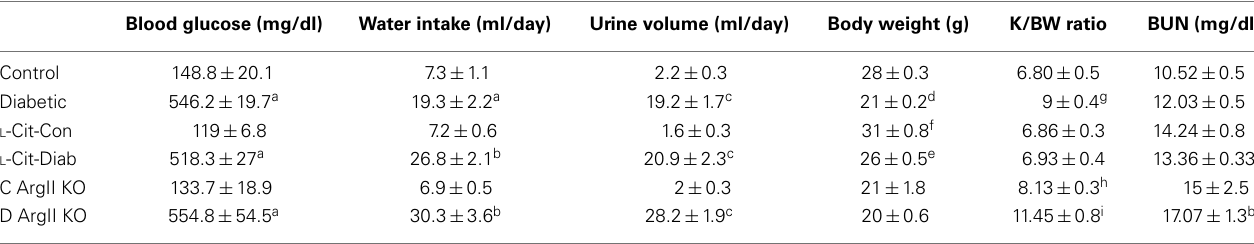
Table 2 | Biochemical and physical characteristics of study groups after 16weeks. Effect of L -cit supplementation andArgII deletion. Blood glucose (mg/dl)